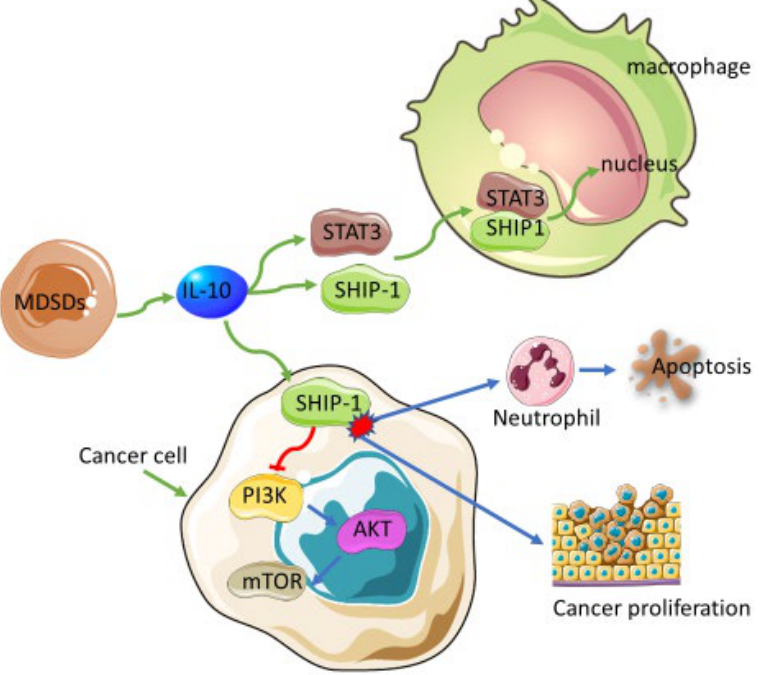
Figure 3. Tumor-associated MDSCs are the predominant suppliers of IL-10. The immunoregulatory effect of MDSCs and associated anti-inflammatory cytokines trigger the induction of the SHIP signaling pathway by cancers. This pathway is interlinked with the PI3K signaling pathway, which suppresses anticancer responses and promotes cancer progression via immune evasion. IL-10 also induces the anti-inflammatory effect of macrophages, thus potentially initiating their polarization into cancer-favoring M2 macrophages. Downregulated SHIP expression has also been shown to induce apoptosis in neutrophils needed for the destruction of cancer cells.